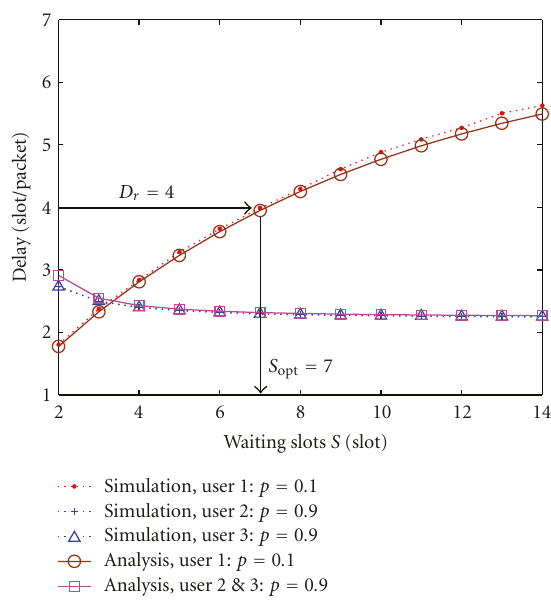
Figure 4: Delay performance of individual users.